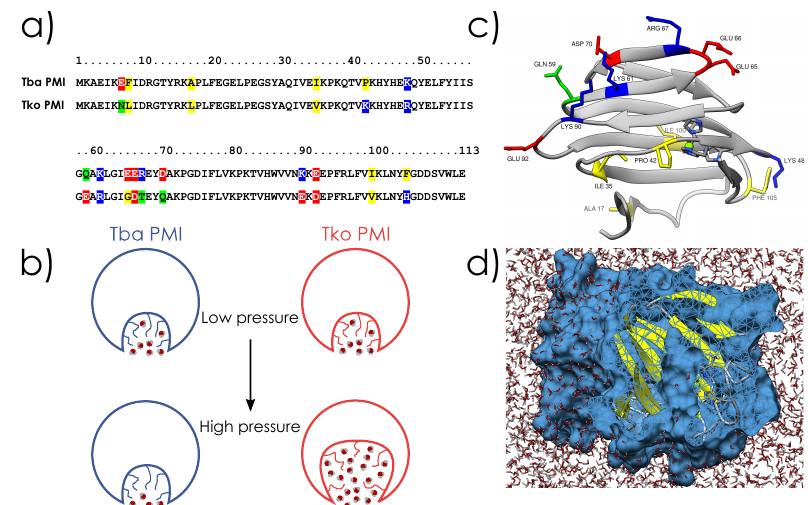
Figure 9. ( a ) sequence alignment of the two proteins, substitutions are highlighted (red for acidic, blue for basic, green for polar and yellow for hydrophobic residues). ( b ) schematic representation of the two proteins and effect of high pressure on them. ( c ) cartoon representation of Tba PMI, substitutions are represented in sticks with the same color-code as ( b ). ( d ) vertical cut on the surface representation of Tba PMI, highlighting the ligand